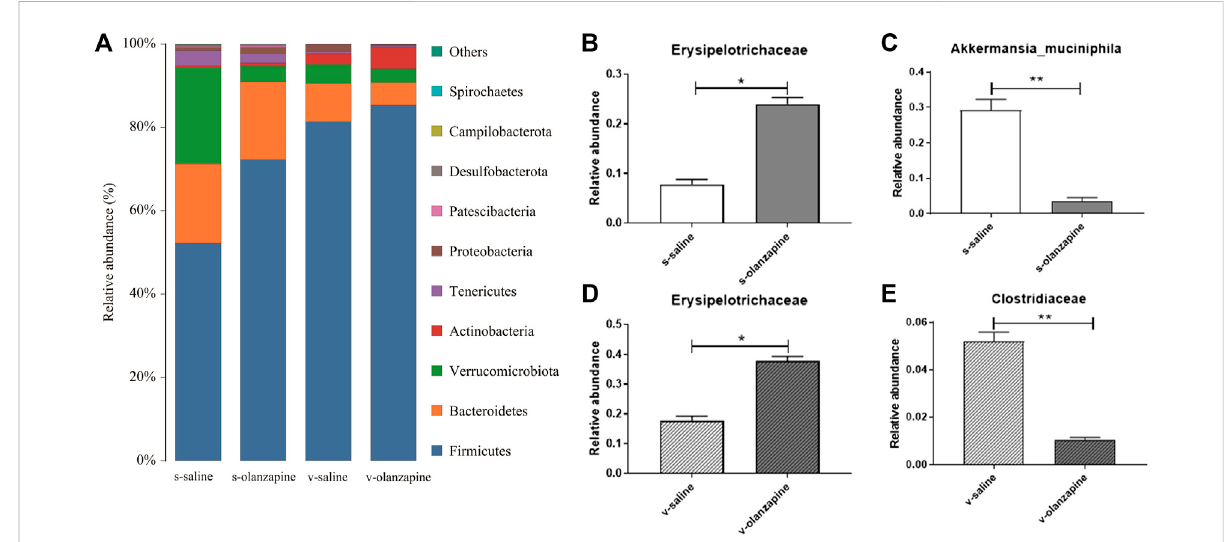
FIGURE 3 Gut microbial species distribution in the four groups: histograms showing species distribution at each phylum level (A) ; difference analyses of Erysipelotrichaceae (B) and Akkermansia muciniphila (C) between the olanzapine-administered and saline groups under the sham-operated condition; and comparisons of Erysipelotrichaceae (D) and Clostridiaceae (E) between the olanzapine administrated and saline groups under the vagotomy condition. * p < 0.05 and ** p <